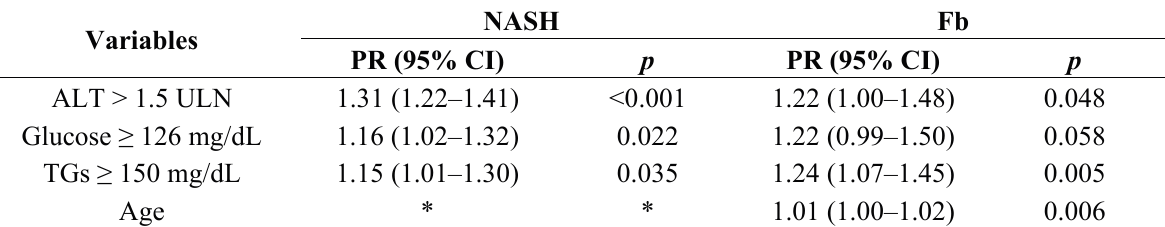
Table 2. Multivariate analysis according to the presence of NASH and fibrosis.